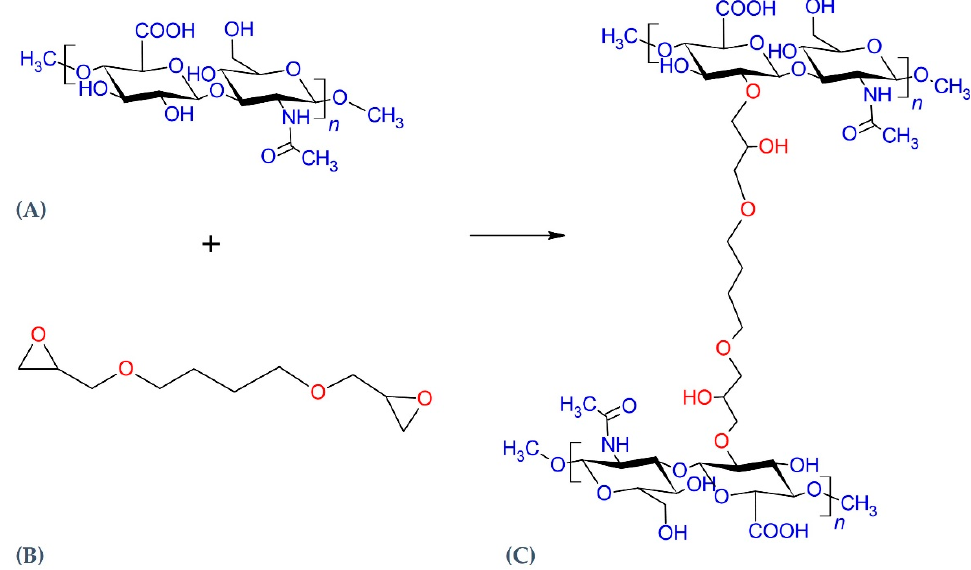
Figure 1. Schematic illustration of cross-linking reaction between hyaluronic acid (HA) ( A ) and the (1,4-butanediol diglycidyl ether) BDDE cross-linking agent ( B ). Under alkaline conditions the BDDE epoxy groups react with the hydroxyl HA group, leading to ether bond formation ( C ). Image obtained with ChemSketch 2020.1.2 (Advanced Chemistry Development, Inc., Toronto, CA, Canada).